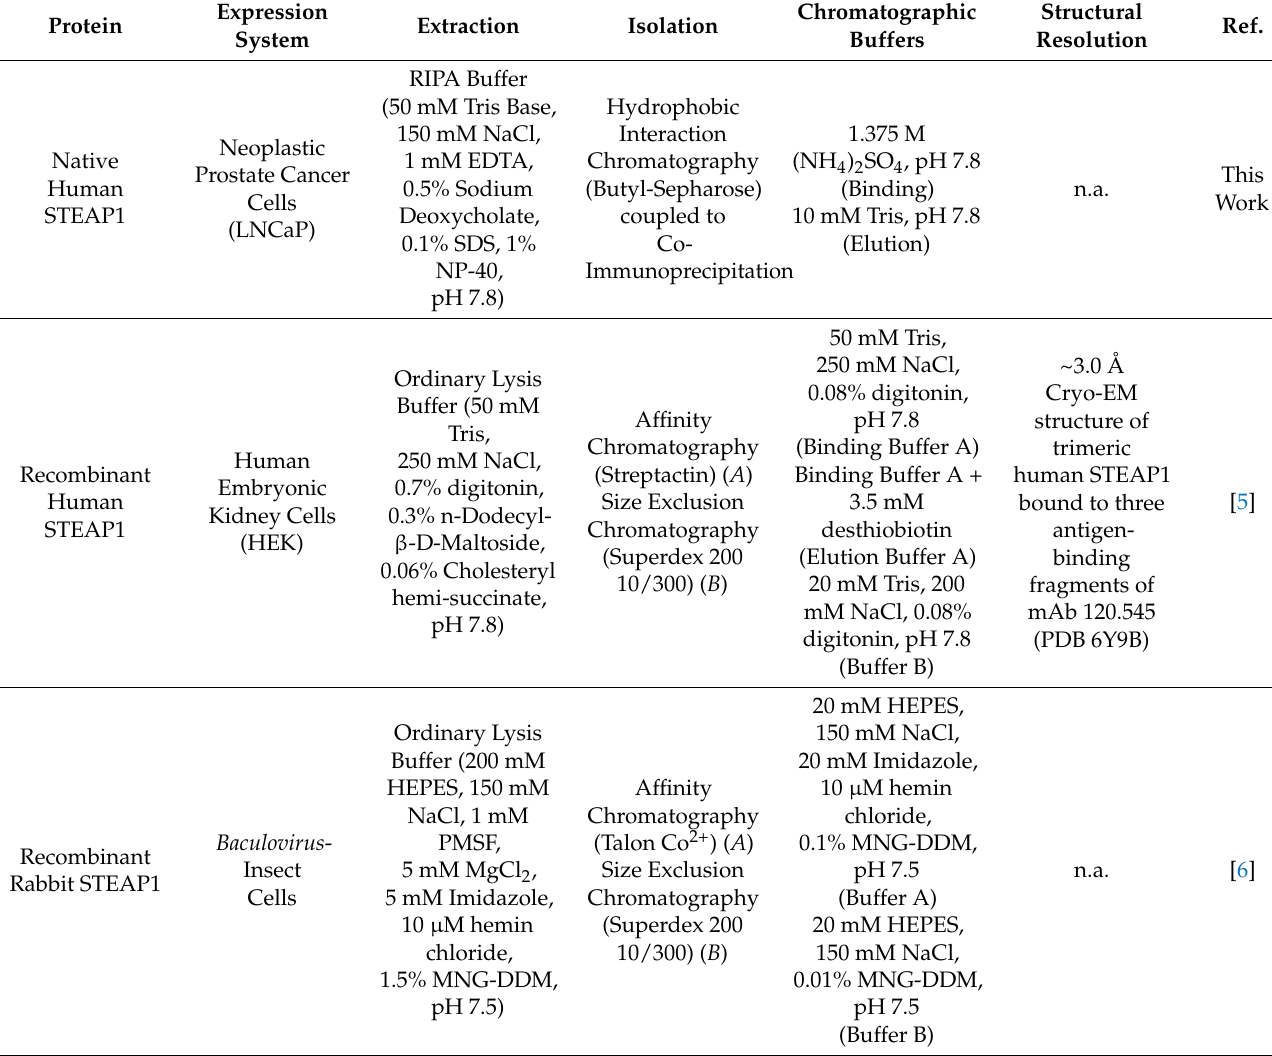
Table 1. Integrative overview of overall existent strategies from the biosynthesis to the isolation of STEAP1 counterparts towards their structural resolution and